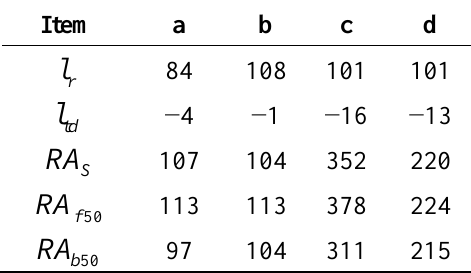
Table 2. The terrain drop measurement results corresponding to Figure